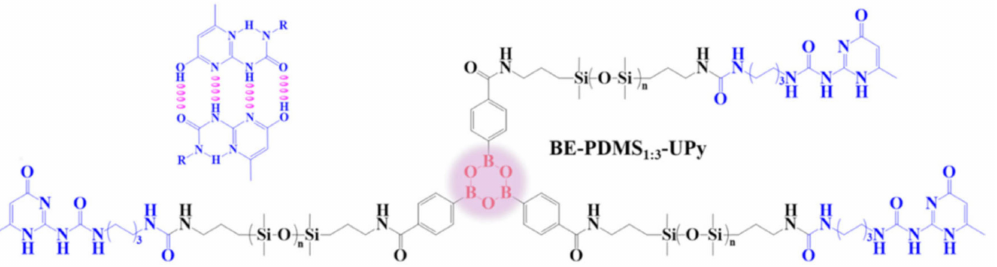
Figure 8. Chemical structure of BE-PDMS1:3-UPy. Adapted with permission from Reference [111]. Copyright (2020) American Chemical